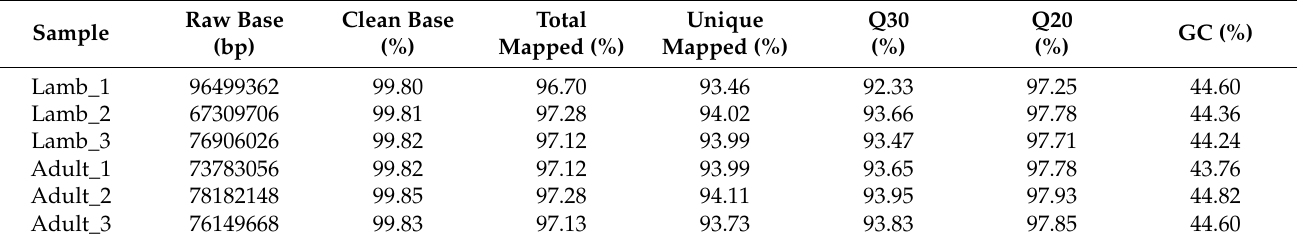
Table 1. Sequence data